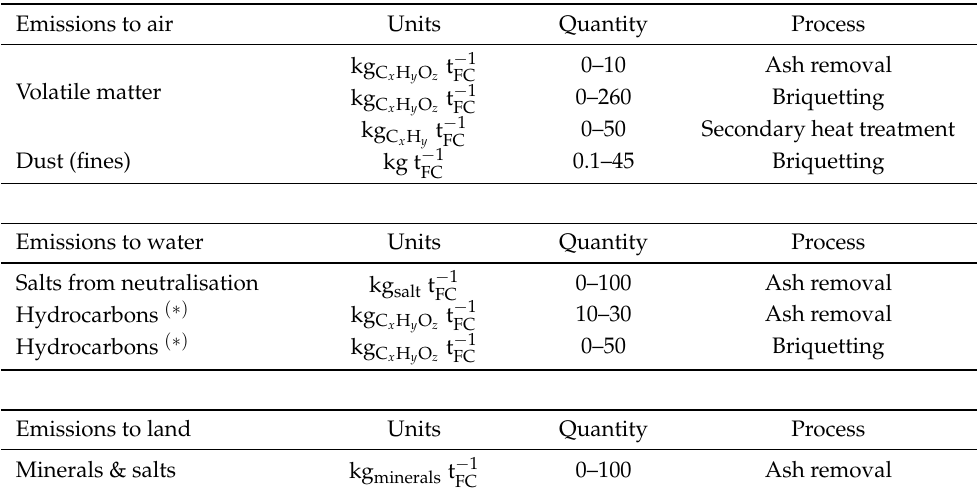
Table 9. Life cycle inventory analysis for possible additional